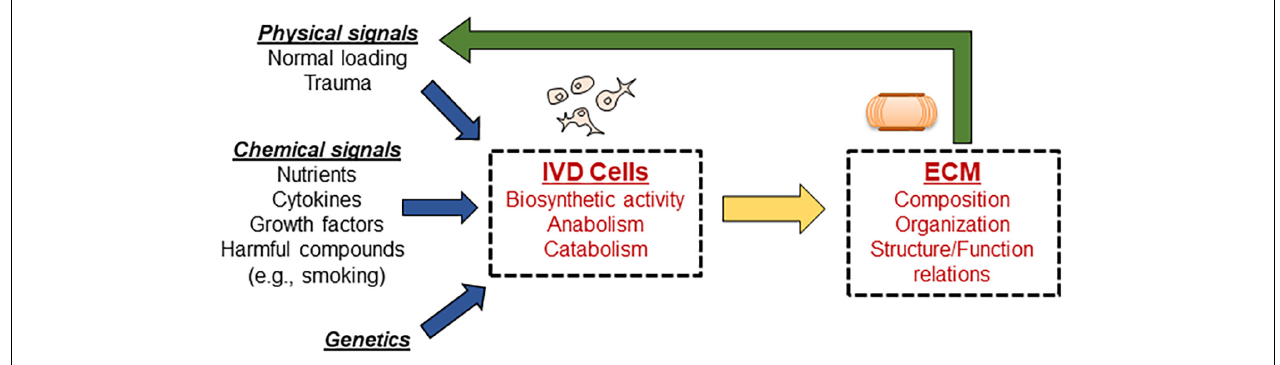
FIGURE 1 | Schematic showing the complex interplay of events responsible for maintaining disc homeostasis. Disc cells are responsible for maintaining the ECM; any alteration to input signals guiding cellular biosynthesis results in altered disc ECM properties, which further alters signaling in a cyclic fashion. Computational modeling can be used to isolate the effects of individual signals, as well as investigate the combined